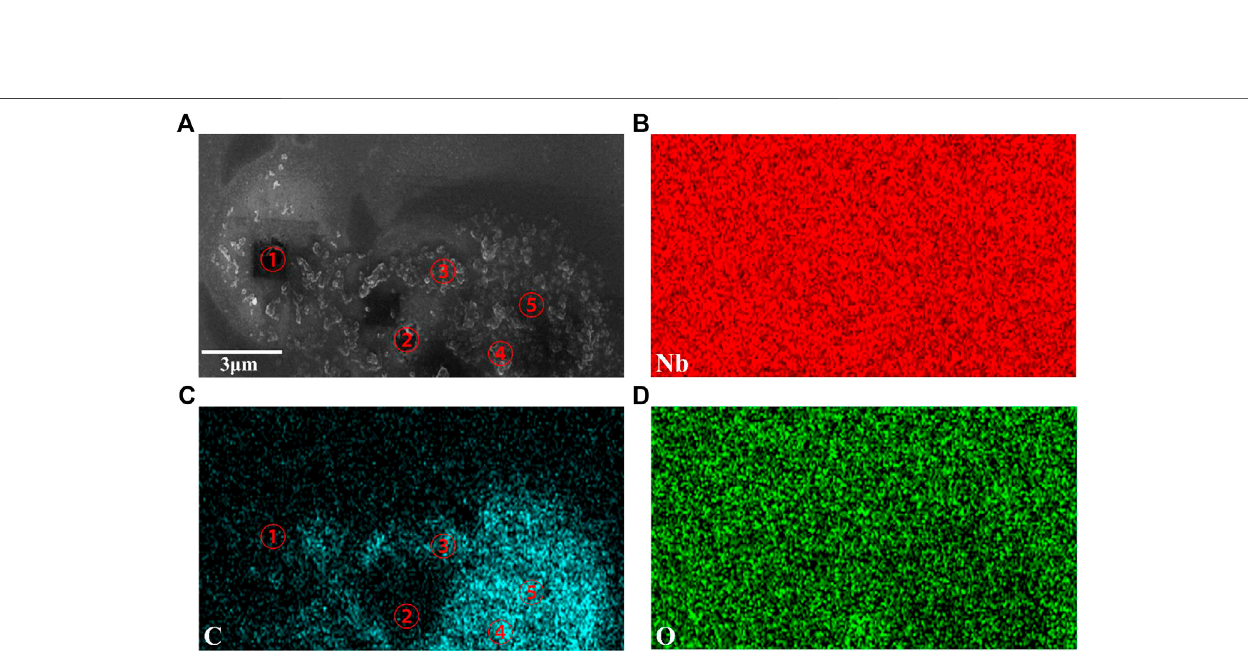
Frontiers in Materials |